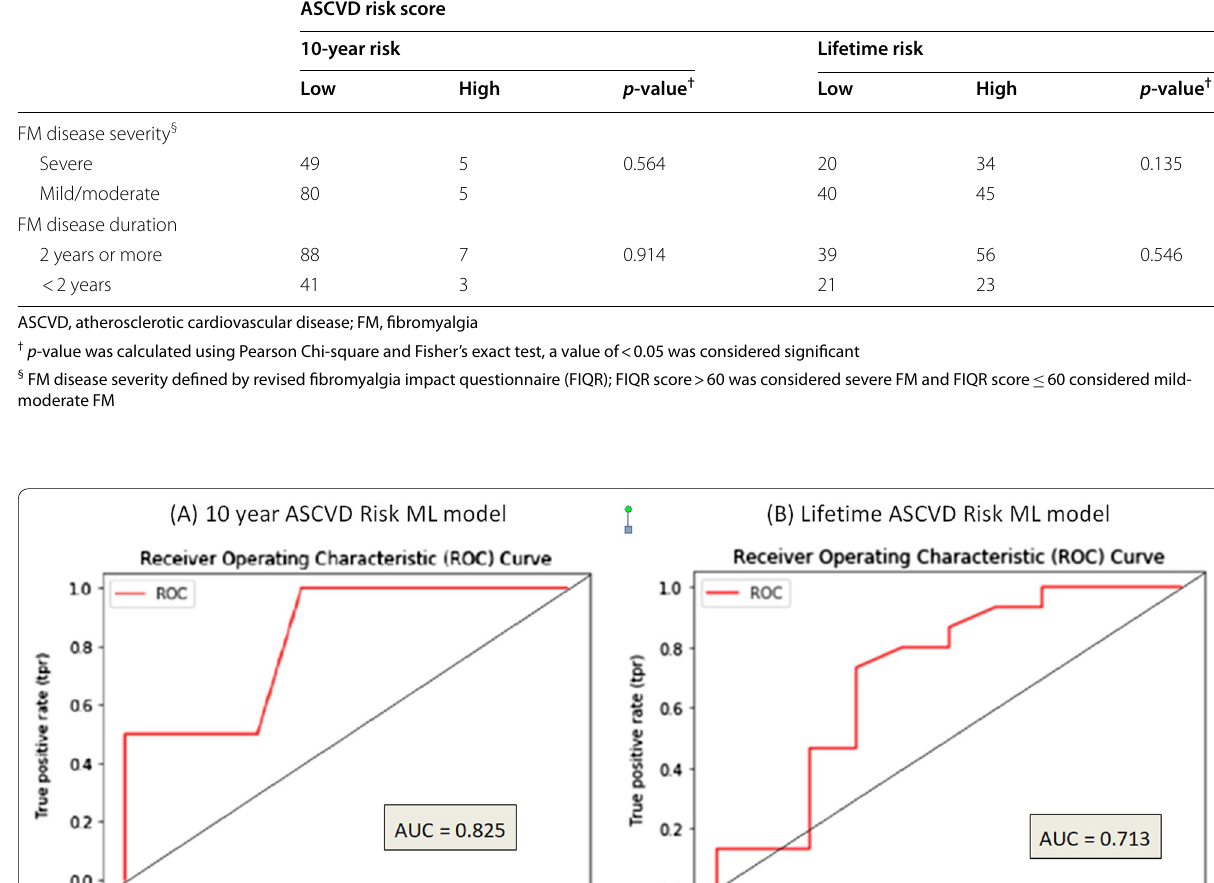
Table 3 ASCVD risk scores stratified for FM disease severity and duration